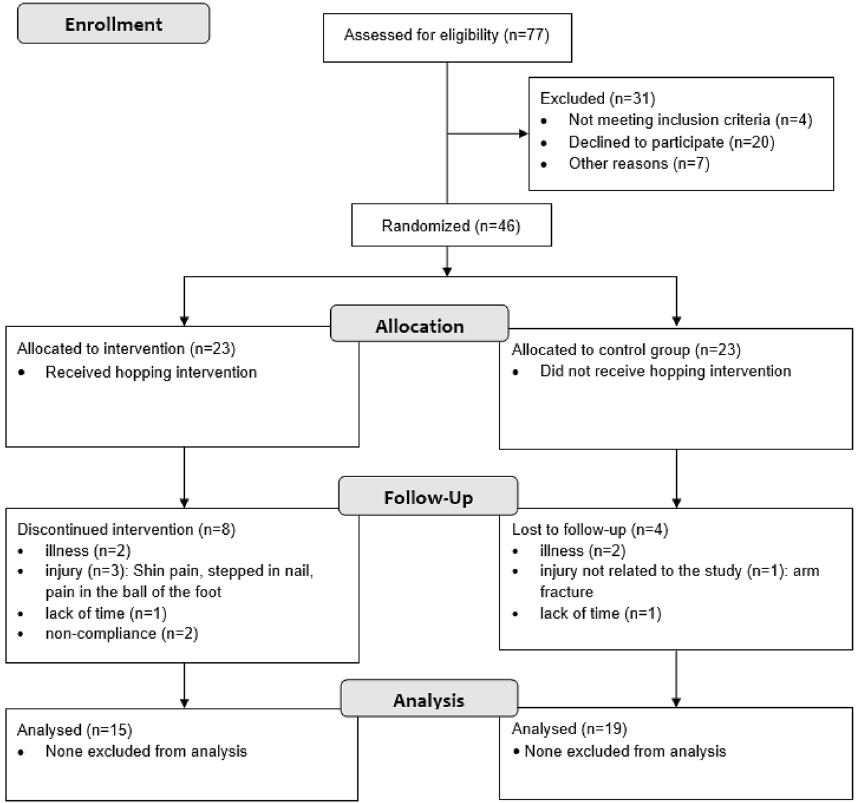
Figure 1. Flow chart of the study.